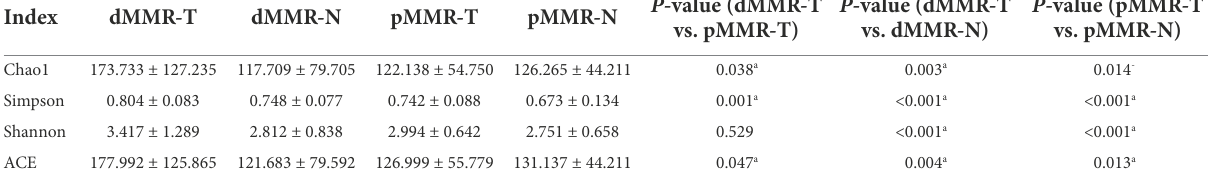
TABLE 3 Microbial alpha-diversity index comparisons.